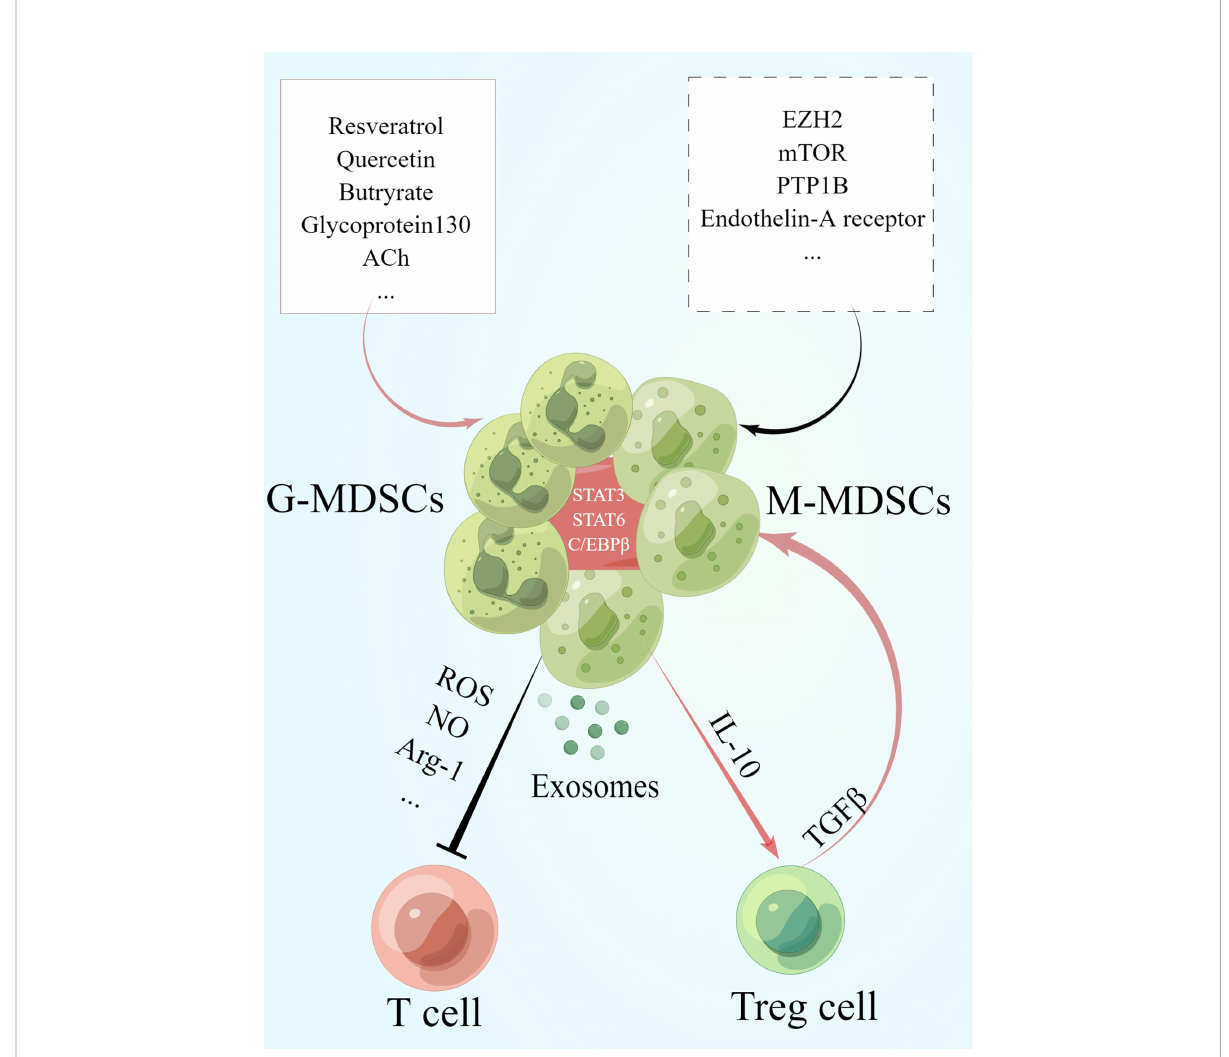
FIGURE 1 MDSCs and their immune regulatory effects on T cells. During the recovery phase of IBD, MDSCs exert their suppressive effects on T cells by secreting cytokines such as Arg-1, NO and ROS as well as exosomes expressing these cytokines. Meanwhile, MDSCs induce the increase of Treg cells via IL-10. Treg cells secret TGF- b to enhance the suppressive function of MDSCs in turn and speci fi cally increase the number of M-MDSCs. The activation of signals in MDSCs such as STAT3, STAT6 and C/EBP b plays a key role in its functioning. Besides, studies have revealed that the administration of resveratrol, quercetin, acetylcholine (ACh) and so on promotes the generation of MDSCs while the activation of zeste homolog 2 (EZH2), mTOR, protein tyrosine phosphatase 1b (PTP1B) and so on inhibits MDSCs. This graph is drawn by